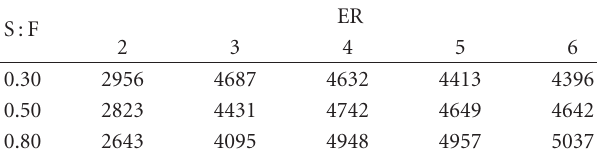
Table 6: HHV of gases (kj/SATPm 3 ).